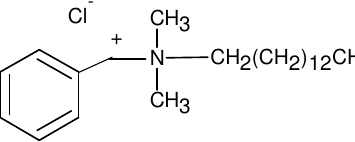
Figure 1. Structure of benzalkonium chloride